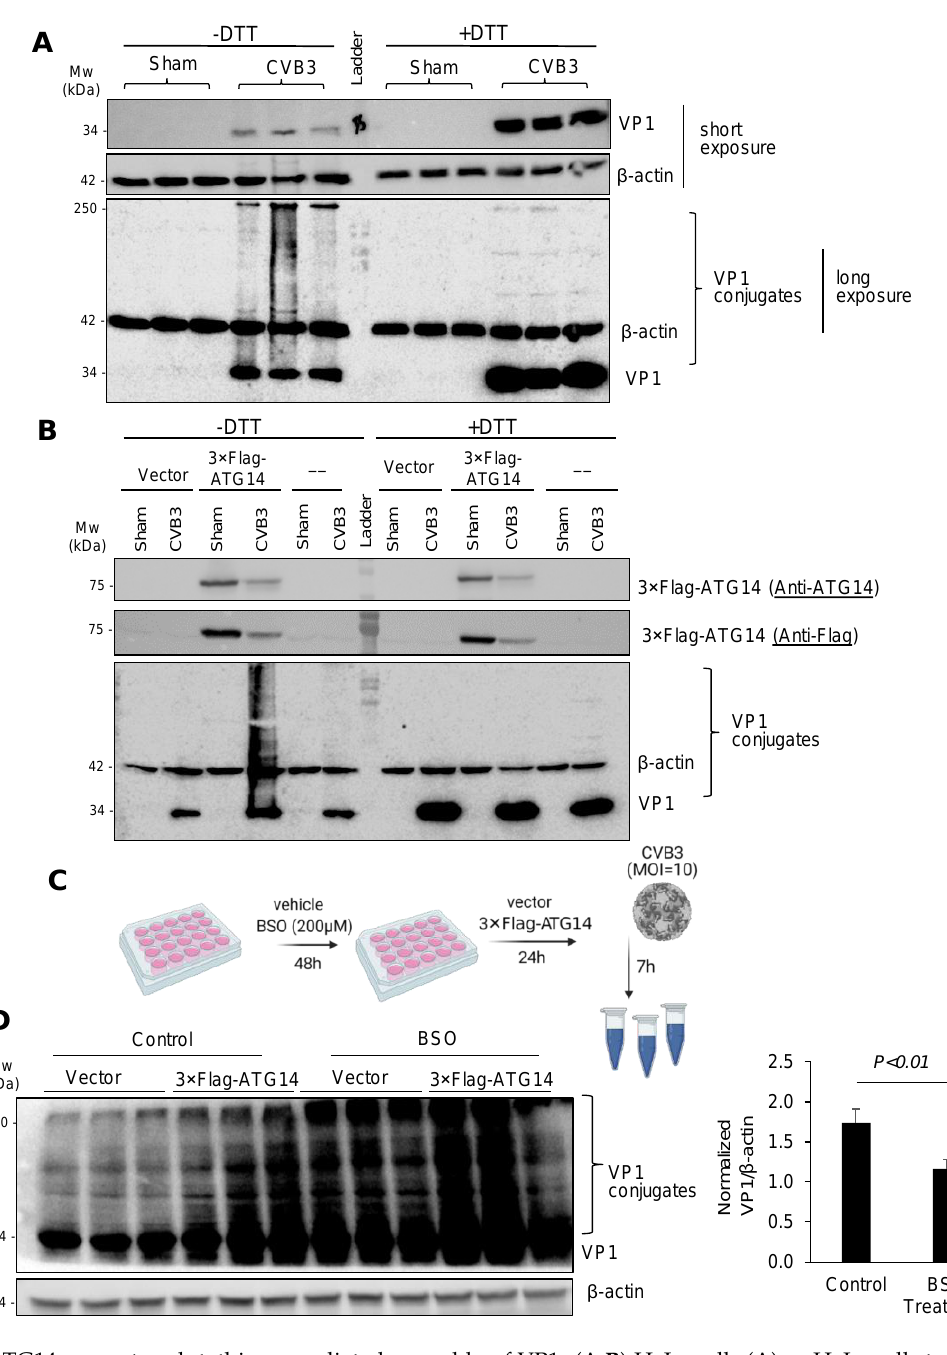
Figure 5. ATG14 promotes glutathione-mediated assembly of VP1. ( A , B ) HeLa cells ( A ) or HeLa cells transfected with 3 × Flag-ATG14 ( B ) were sham- or CVB3-infected (MOI = 10, 7 h) in the presence or absence of DTT as indicated. Cell lysates were harvested and Western blot was performed to assess monomeric and conjugated VP1. ( C ) Diagram showing the experimental protocol to test if glutathione was involved in disulfide bridge formation, buthionine sulfoximine (BSO: a glutathione synthesis inhibitor). ( D ) HeLa cells were treated with BSO (200 μM) or a vehicle for 48 h, and then transfected with 3 × Flag-ATG14 or an empty vector for 24 h. Subsequently, the cells were infected with CVB3 (MOI = 10) for 7 h. Cell lysates were collected for Western blot analysis. VP1 conjugates in cells expressing 3 × Flag-ATG14 were first normalized to β-actin, and then to the levels of VP1 conjugates in cells expressing empty vectors in both control and BSO-treated groups (mean SEM, n = 3).